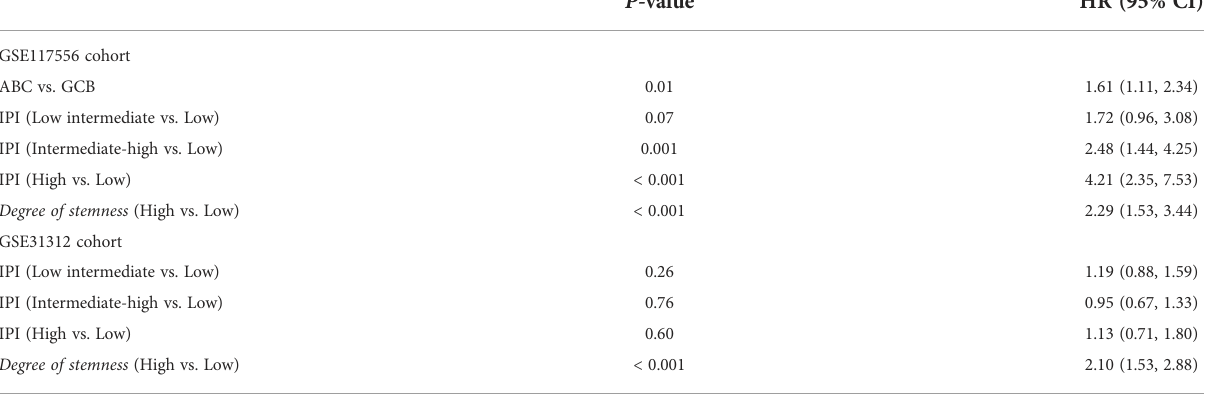
TABLE 3 Multivariable Cox regression analyses of clinical features, degree of stemness and